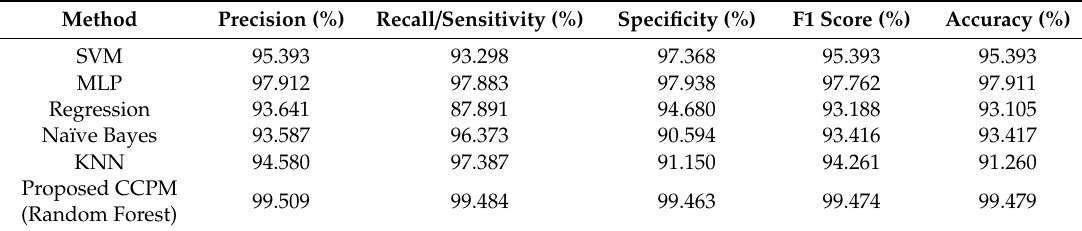
Table 11. Performance evaluation results based on DBSCAN and SMOTETomek for Schiller.